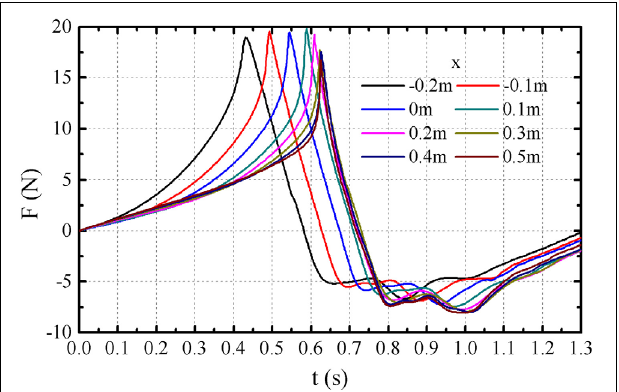
FIGURE 10 | Inline forces at different